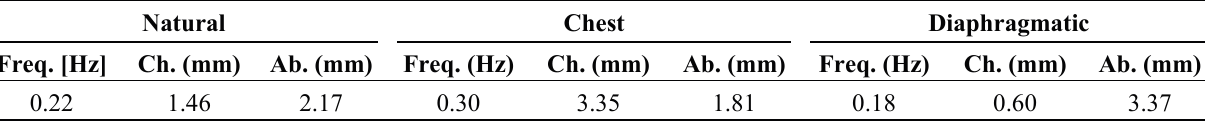
Figure 7. Radar measured signals at ( a ) chest and ( b ) abdomen when the subject was performing diaphragmatic breathing. Table 2. Radar measured natural, chest, and diaphragmatic